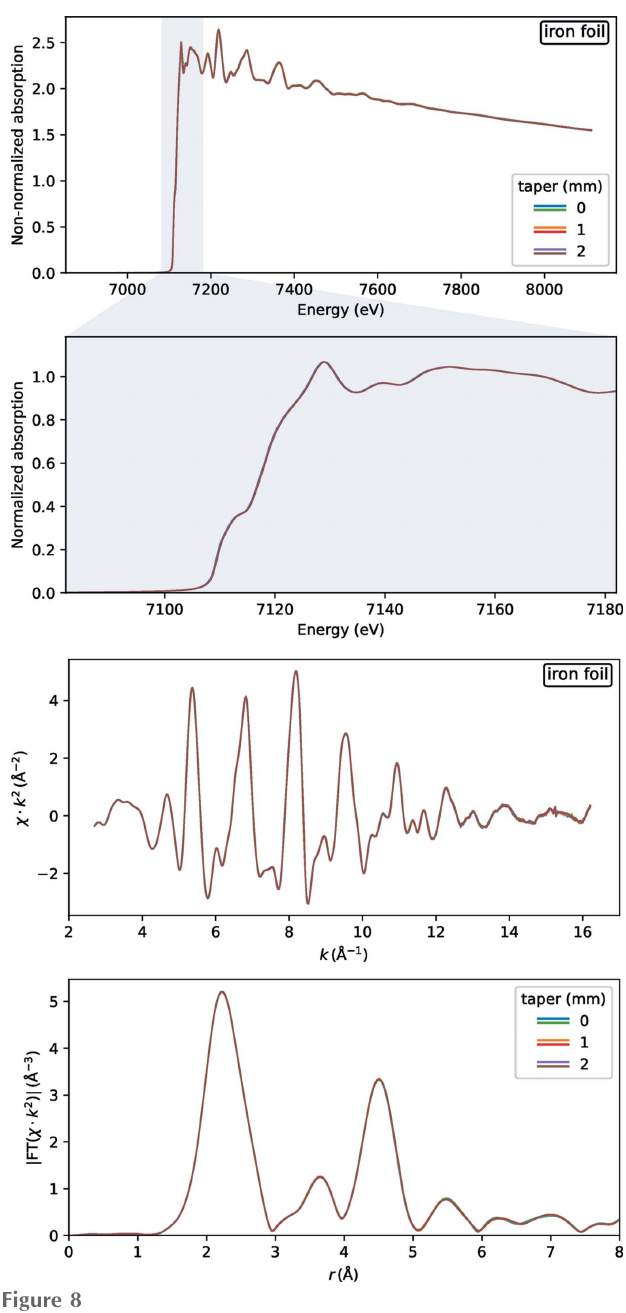
Figure 8 EXAFS spectra for a sample with the most homogeneous thickness: a metal foil. Three values of wiggler gap taper were tested, each with two repeats of EXAFS, six curves in total in each